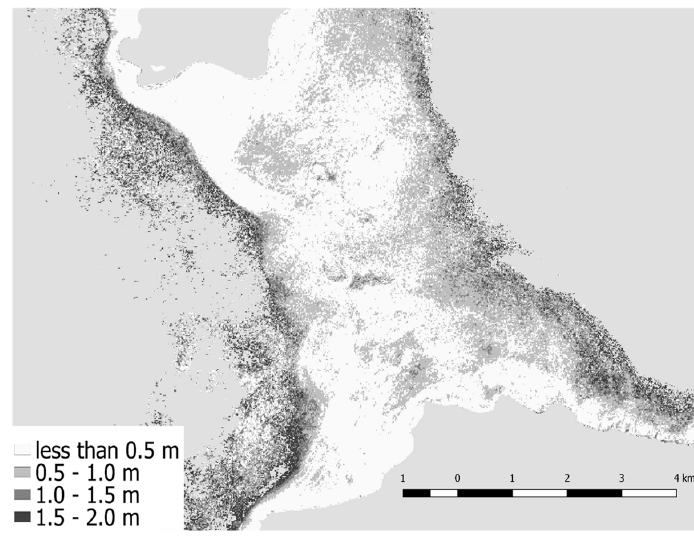
Figure 8. Absolute difference between 4SM retrieved depths and interpolated DTM of groundtruthed depths.